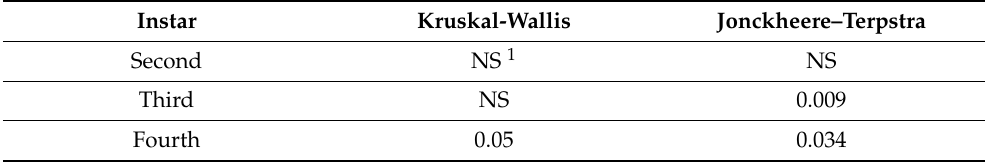
Table 1. Results of Kruskal–Wallis and Jonckheere–Terpsta tests determining whether significant differences exist between the abundance of larvae at different depths in the granular activated carbon (GAC)